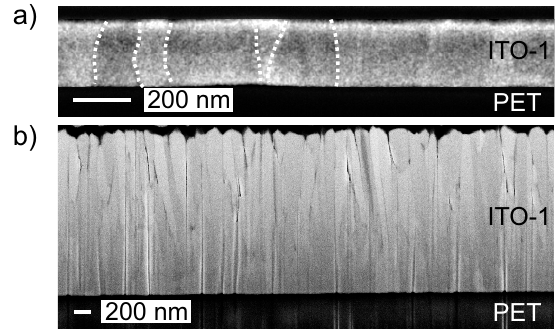
Figure 3. Focused ion beam (FIB) cuts of ( a ) ≈ 200 nm and ( b ) ≈ 2020 nm ITO-1 films. For better visualization, the contrast was enhanced in (a) and grain boundaries are indicated by dotted lines in the left image section. PET: polyethylene